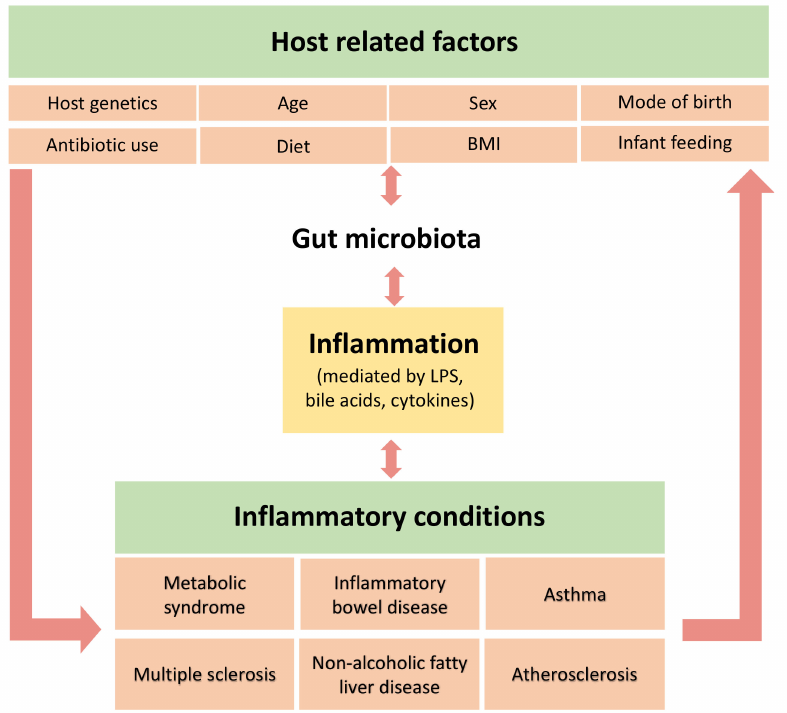
Figure 3. Interrelationships between the gut microbiota, inflammation and inflammatory conditions. The gut microbiota is shaped by various factors and has a bidirectional relationship with diet and BMI. It also has a bidirectional relationship with inflammation and depending on its composition, it can inhibit or stimulate inflammatory pathways. These, in turn, can promote the onset of various inflammatory